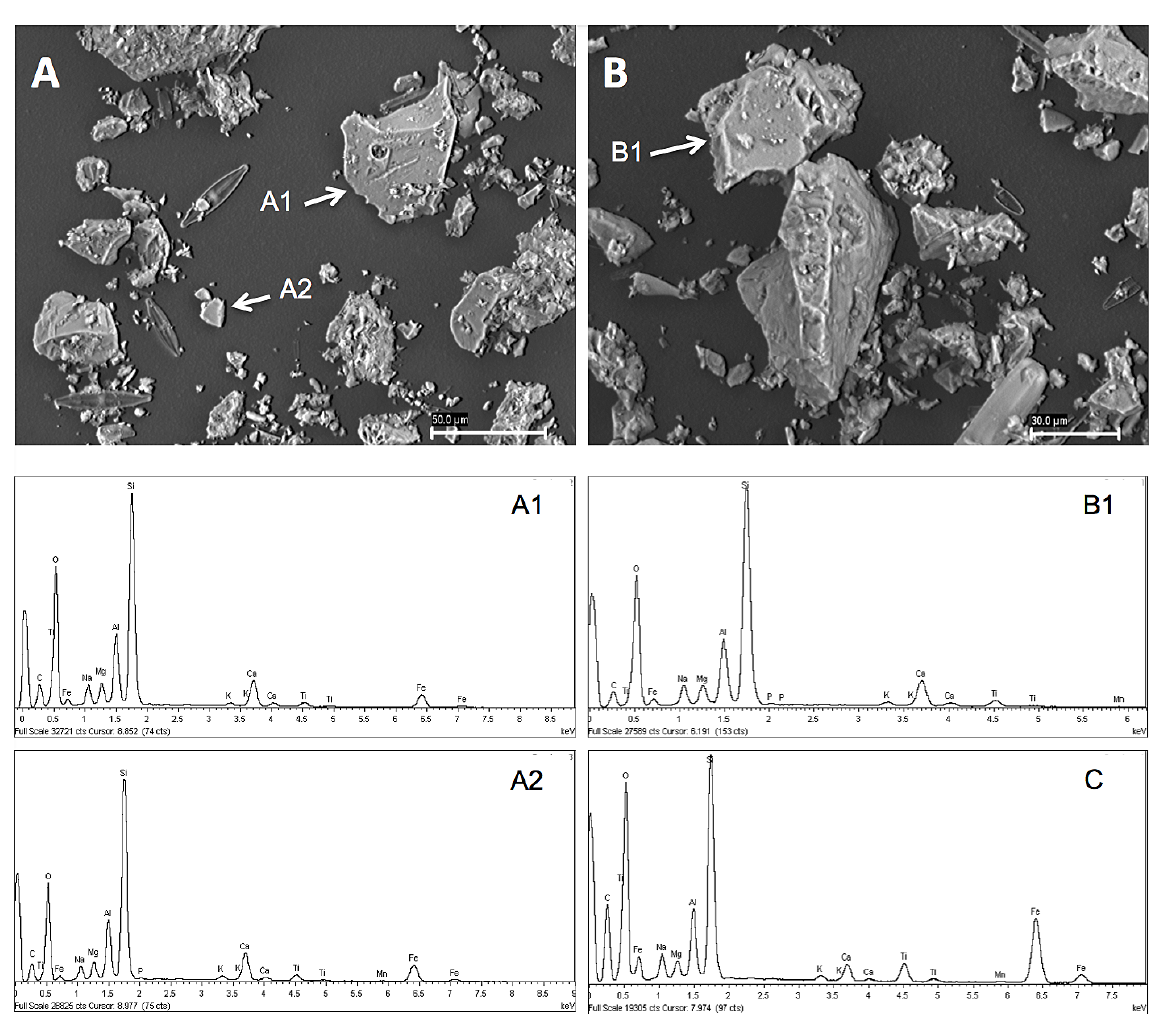
Figure 5. Selected SEM microphotographs showing the presence of volcanic shards in Ca-rich layers of sediments of the core LIM03/1 of Limnopolar Lake, and EDS analyses of their composition. A1, A2 and B1 correspond to the shards coded in the microphotographs (A) (tephra at 18cm) and (B) (tephra at 6.8cm); (C) (tephra at 6.8cm) is an example of a shard richer in Fe and Ti (not shown in the